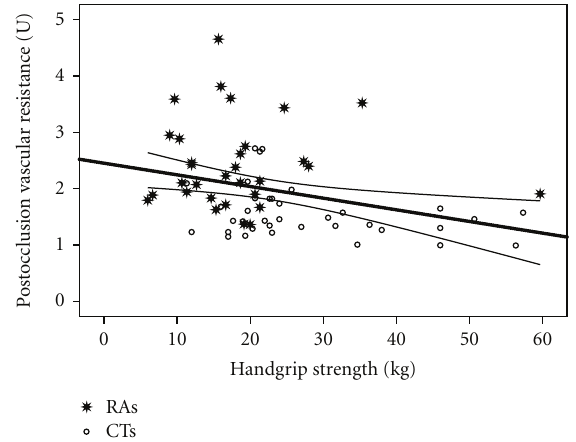
Figure 5: Relationship between handgrip strength and postocclu- sion vascular resistance. r = − 0 . 32; P = 0 .